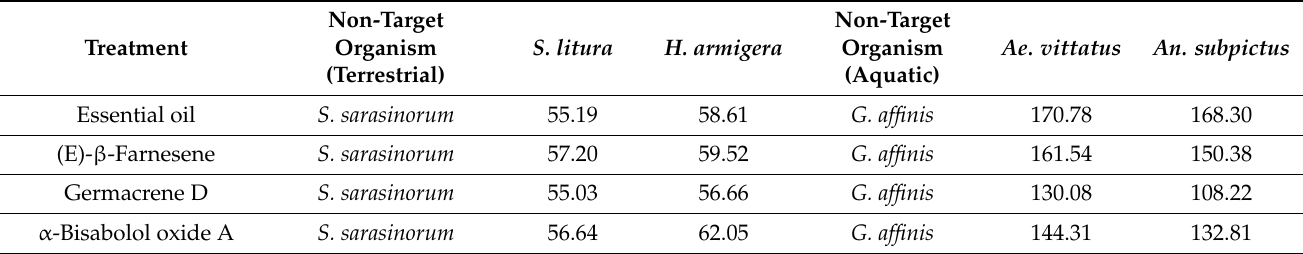
Table 8. The suitability index of aquatic and terrestrial non-target fauna is shared by several agricultural and medicinal pests exposed to Matricaria chamomilla essential oil and its major